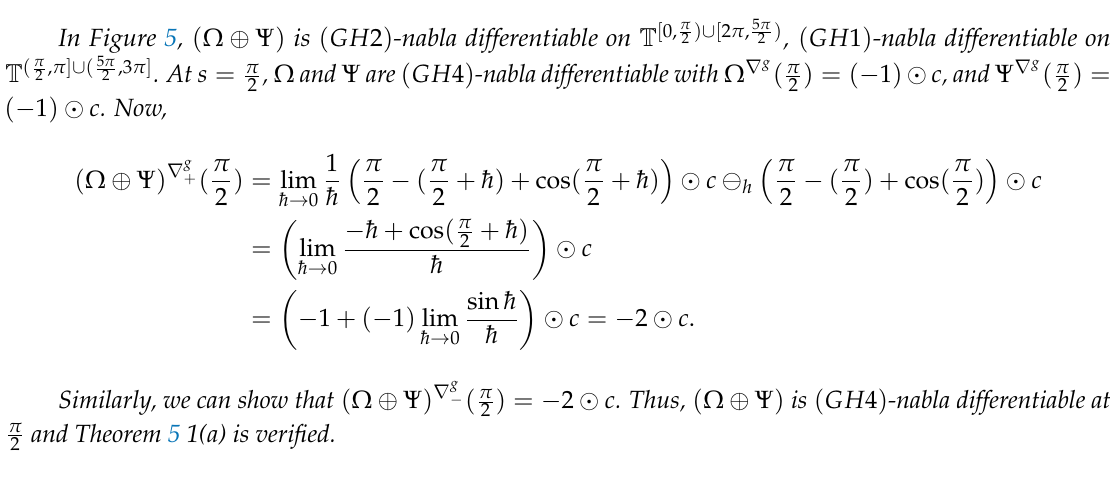
Figure 4. Graphical Representation of Ψ ( s ) in Example